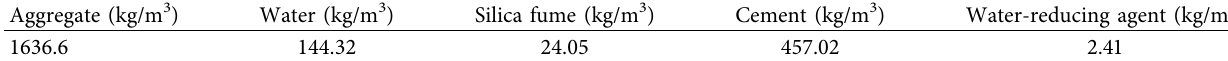
Table 3: mixture ratio of ordinary permeable concrete.